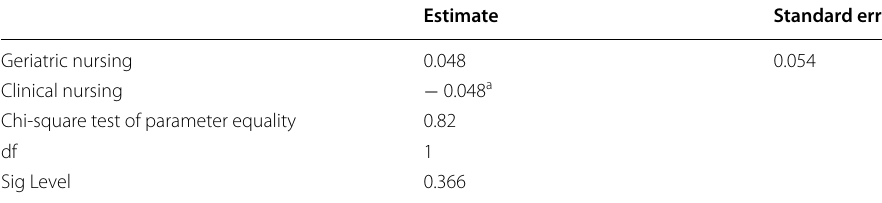
Table 10 Global DIF analysis to identify subgroup invariance between specializations